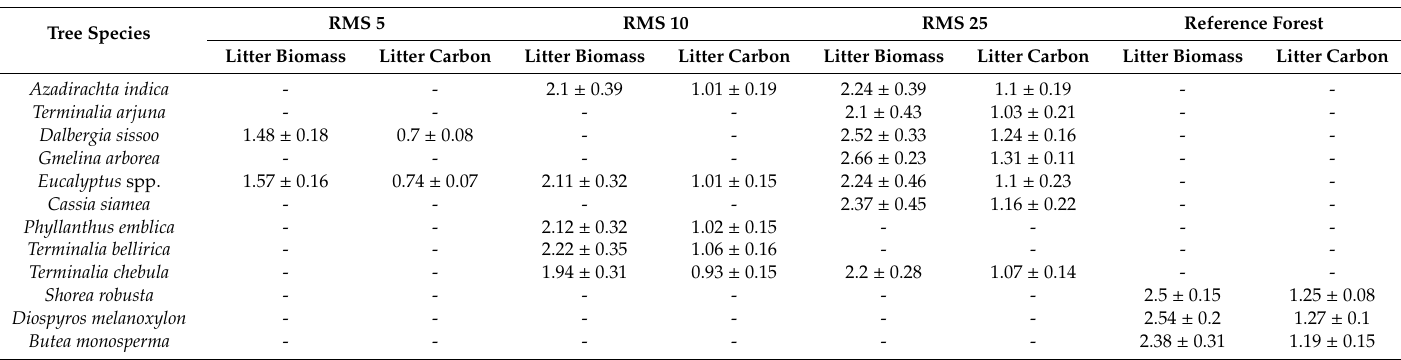
Table 4. Estimation of tree litter biomass (Mg ha − 1 ) and litter carbon stock (Mg ha − 1 ) by tree species of reclaimed chronosequence dumps and reference forest site (mean ± SE, n =